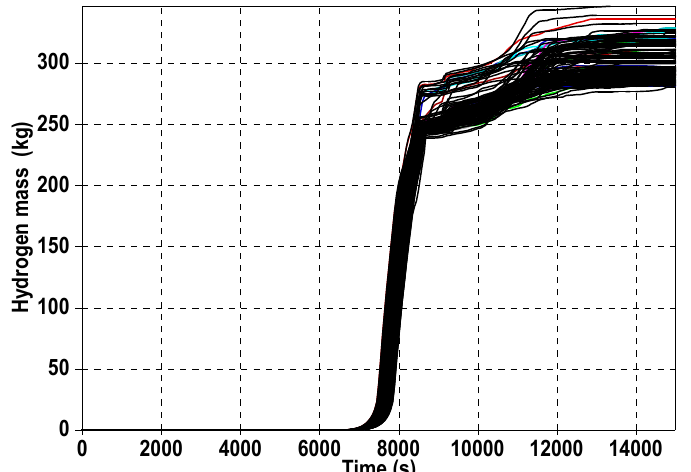
Figure 6. Production of hydrogen.